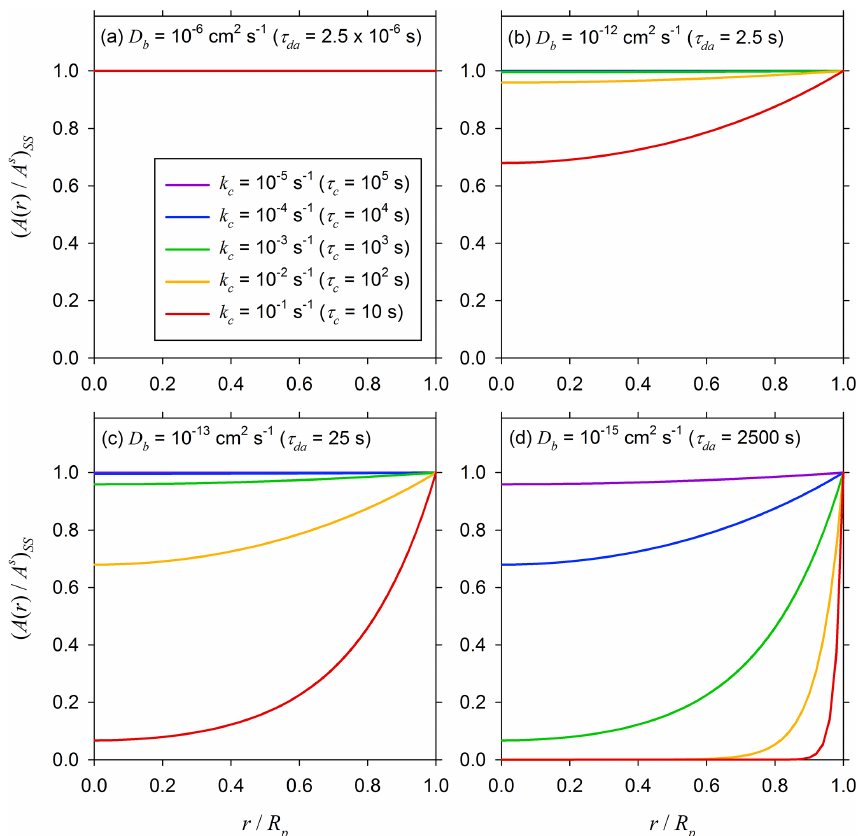
Figure 3. Normalized steady-state concentration (A(r)/A s ) SS profiles as a function of r/R p for a particle of diameter R p = 0.05µm and a range of k c values for (a) D b = 10 − 6 cm 2 s − 1 , (b) D b = 10 − 12 cm 2 s − 1 , (c) D b = 10 − 13 cm 2 s − 1 , and (d) D b = 10 − 15 cm 2 s − 1